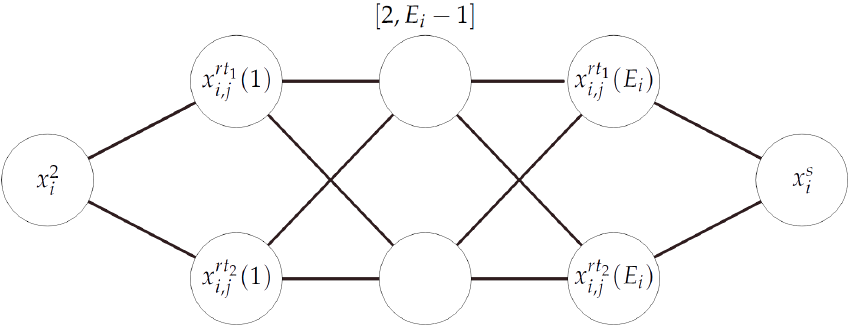
Figure 3. Subnetwork to handle strings that cannot exit the node x i